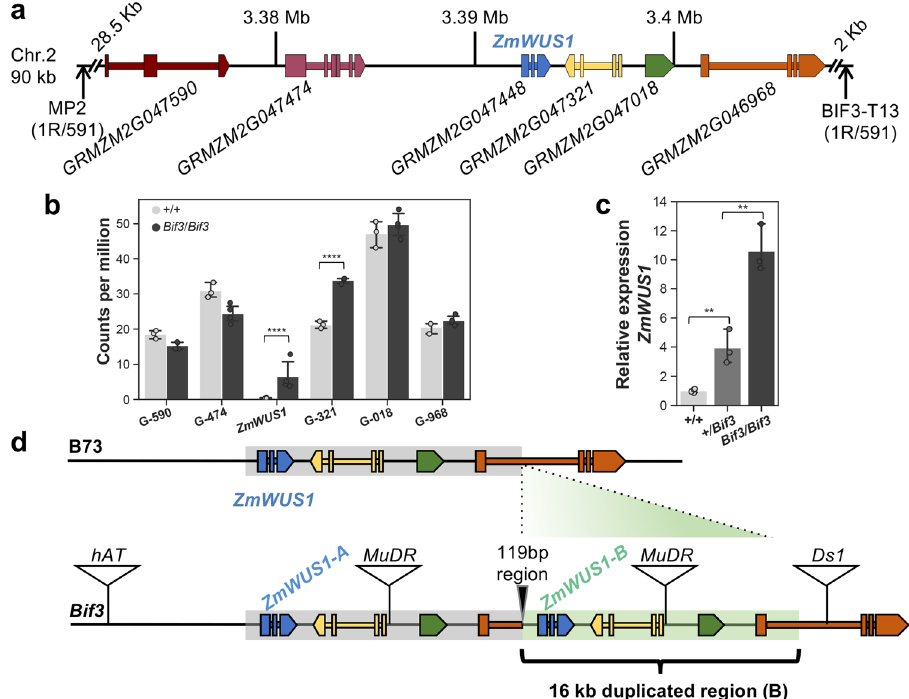
Fig. 2 Bif3 gene identi fi cation. a Map-based cloning of Bif3 (in parenthesis, number of recombinants R/total chromosomes). b RNA-seq analysis of genes (G) in the mapping window indicates that ZmWUS1 is differentially expressed (fold-change = 13.6); two-tailed Student ’ s t -test **** p < 0.0001). n + / + = 3, n Bif3 = 4 ( n pools of three ear samples). Plotted data represent mean ± standard deviation. c qRT-PCR of ZmWUS1 in immature ears; two-tailed Student ’ s t -test ** p < 0.01; n + / + = 4, n + / Bif3 = 3, n Bif3 / Bif3 = 3 ( n pools of three ear samples). Plotted data represent mean ± standard deviation. d Structure of the tandem-duplicated ZmWUS1 locus in the Bif3 mutant. A 16 kb fragment containing ZmWUS1 was duplicated and inserted in the fi rst intron of GRMZM2G046968 . Triangles represent transposon insertions from different